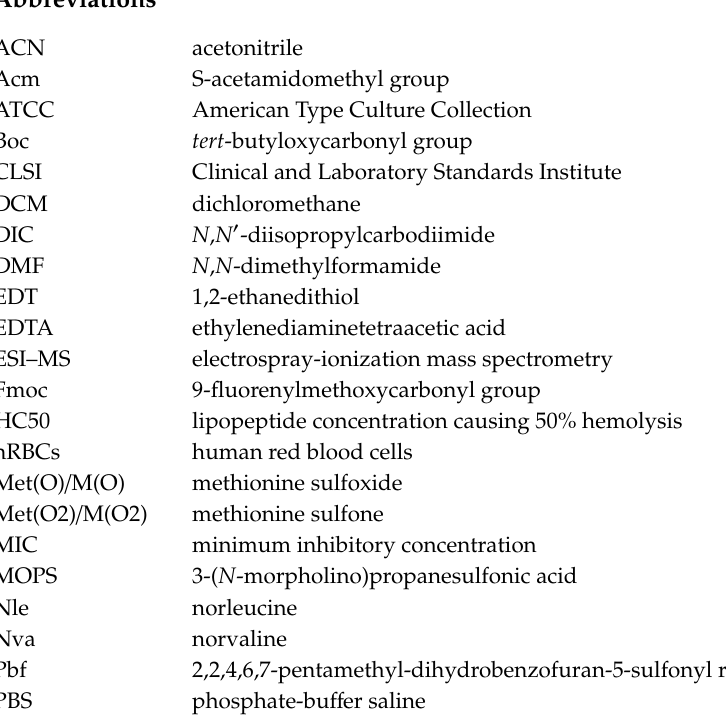
residues against S. aureus vs. tR’; Figure S4: The log 2 MIC of lipopeptides with aliphatic amino acid residue against P. aeruginosa vs. tR’; Figure S5: The log 2 MIC of lipopeptides with aromatic amino acid residue against P. aeruginosa vs. tR’; Figure S6: The log 2 MIC of lipopeptides with remaining amino residues against P. aeruginosa vs. tR’; Figure S7: The log 2 MIC of lipopeptides with aliphatic amino acid residue against C. albicans vs. tR’; Figure S8: The log 2 MIC of lipopeptides with aromatic amino acid residue against C. albicans vs. tR’; Figure S9: The log 2 MIC of lipopeptides with remaining amino residues against C. albicans vs. tR’; Table S1: Peptides used in this study (ESI-MS); Table S2: Antimicrobial and hemolytic activities, selectivity indexes and retention time of lipopeptides (1–105); Table S3: Molecular volume of selected